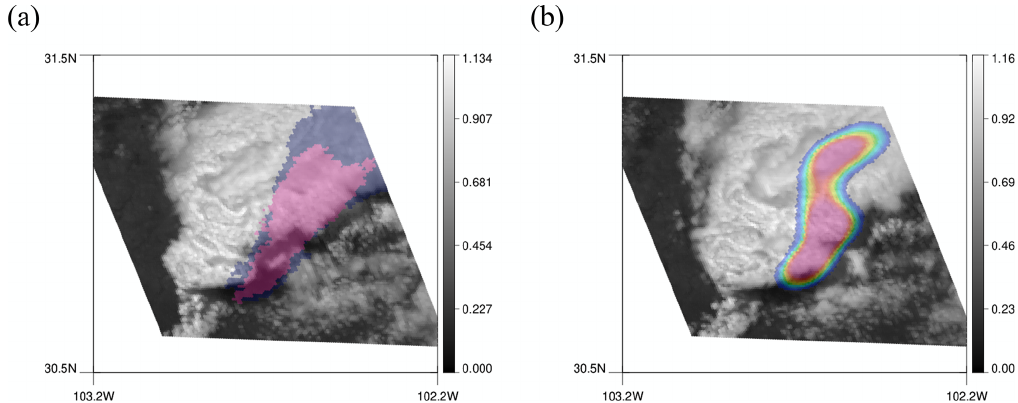
Figure 13. A 128 × 128 tile corresponding to the red box in Fig. 12a. (a) MRMS PrecipFlag on top of the first reflectance image. (b) Predicted convective regions using a threshold of 0.5 on top of the last reflectance